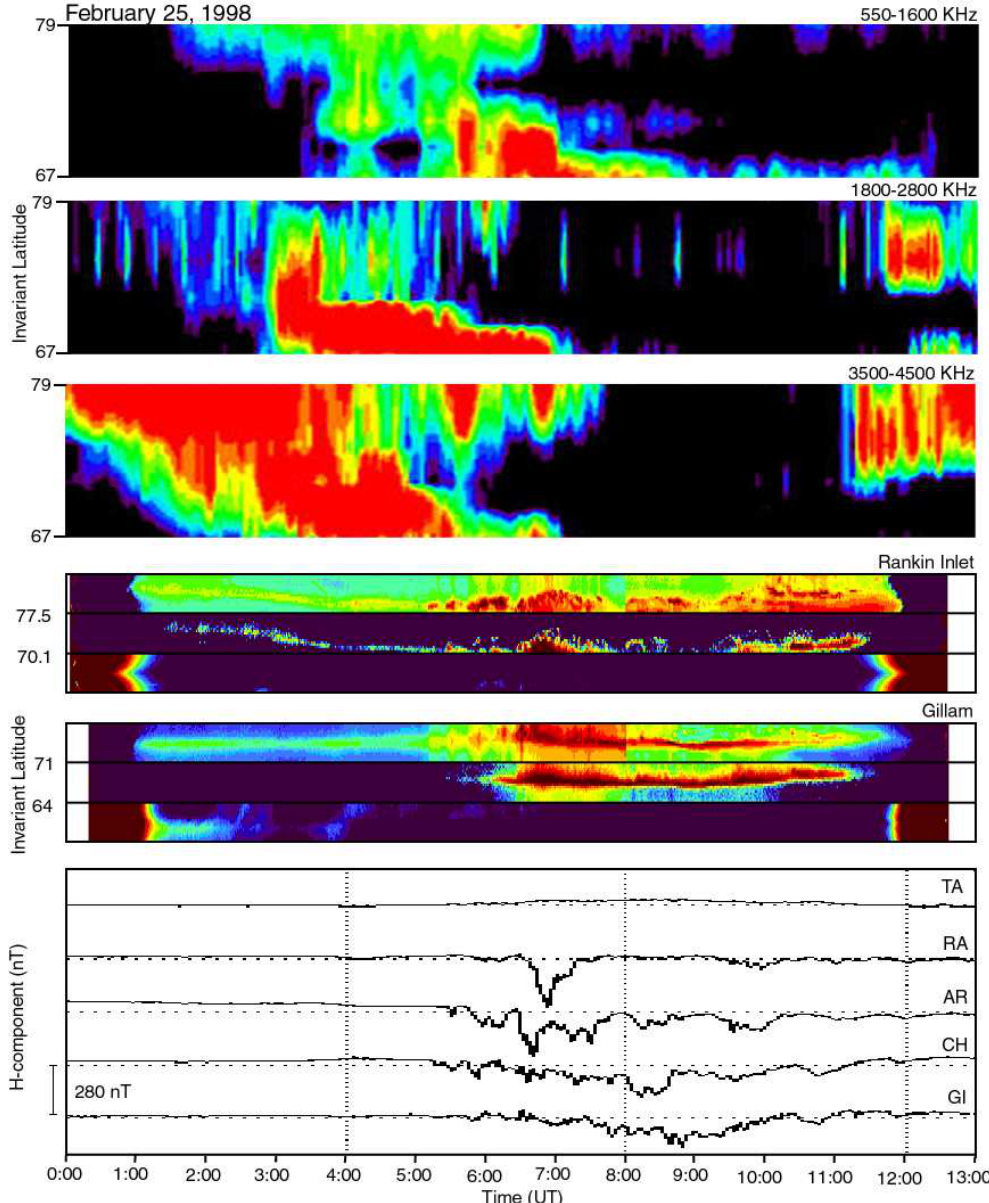
Fig. 11. Data from 00:00–13:00UT on 25 February 1998, in the same format as Fig. 10. In addition to tracking the latitude dependence of auro- ral absorption over several days during magnetic storms, the meridional chain of radio receivers effectively measures spa- day conditions: 3500–4500 kHz (top panel), 1800–2800 kHz